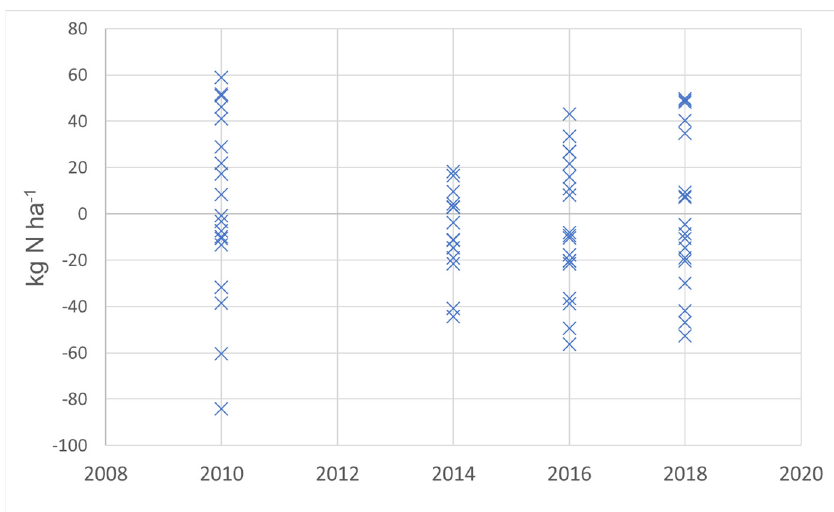
Figure A1. Range of di ff erences in fertilizer N applied and estimated corn grain N removed for four years of available data from 19 reporting US states [5].